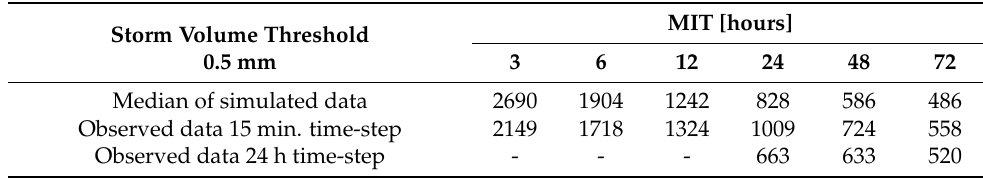
Table 3. Number of independent rainstorm events calculated using 0.5 mm fixed Storm Volume Threshold and different MIT